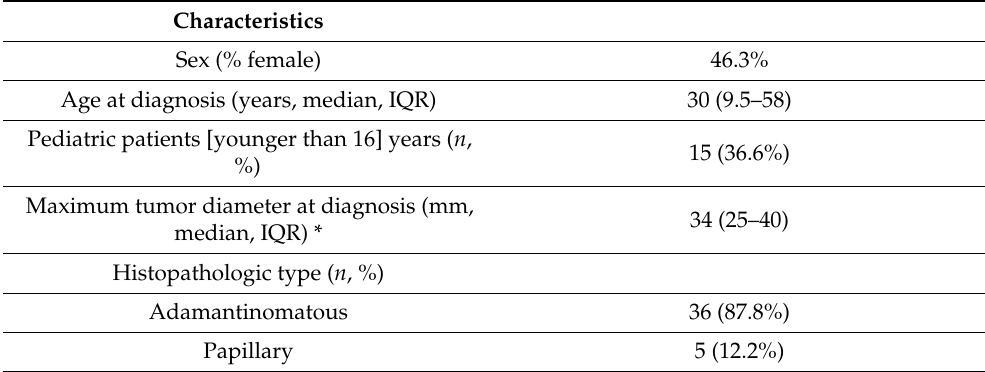
Table 1. Baseline characteristics of the study cohort.